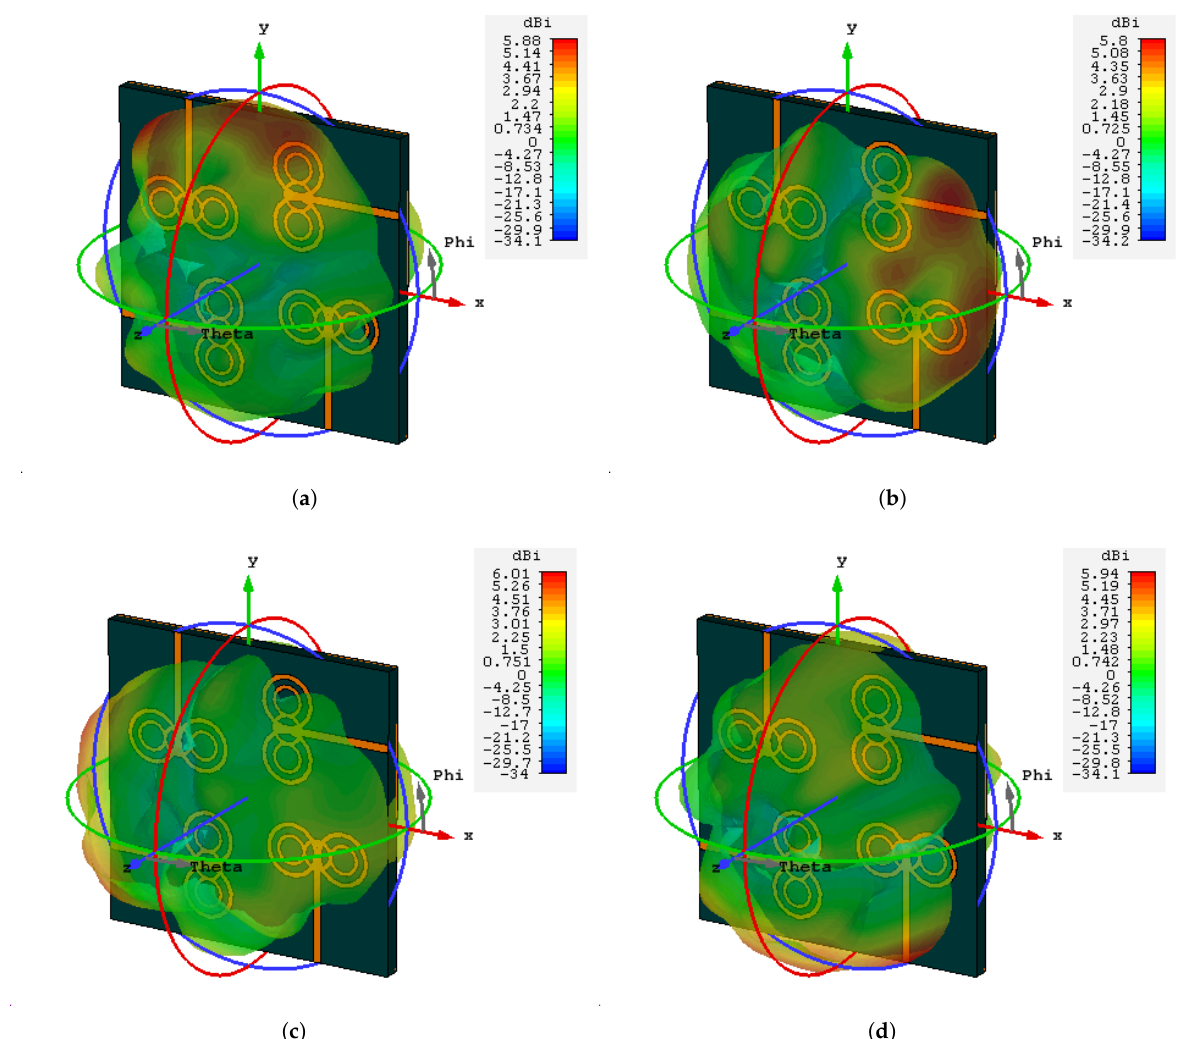
Figure 8. Simulated and measured radiation patterns ( a ) AE-1 ( b ) AE-2 ( c ) AE-3 ( d )